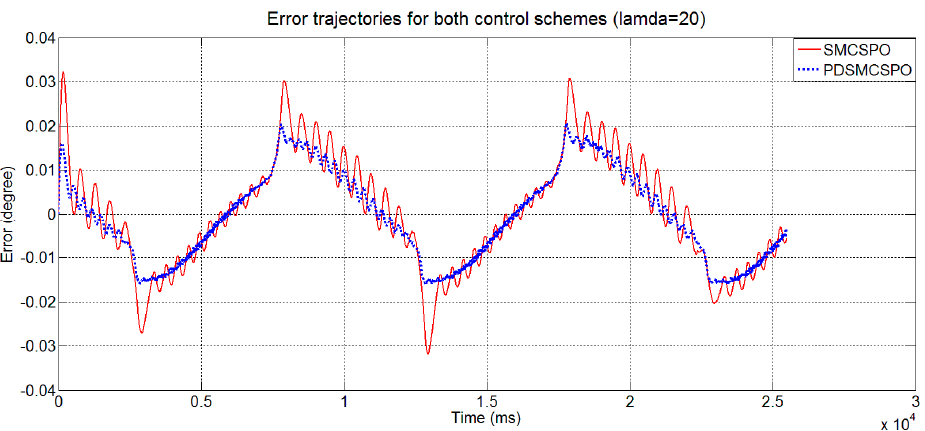
Figure 16. Error trajectories of both control schemes (lambda = 20).